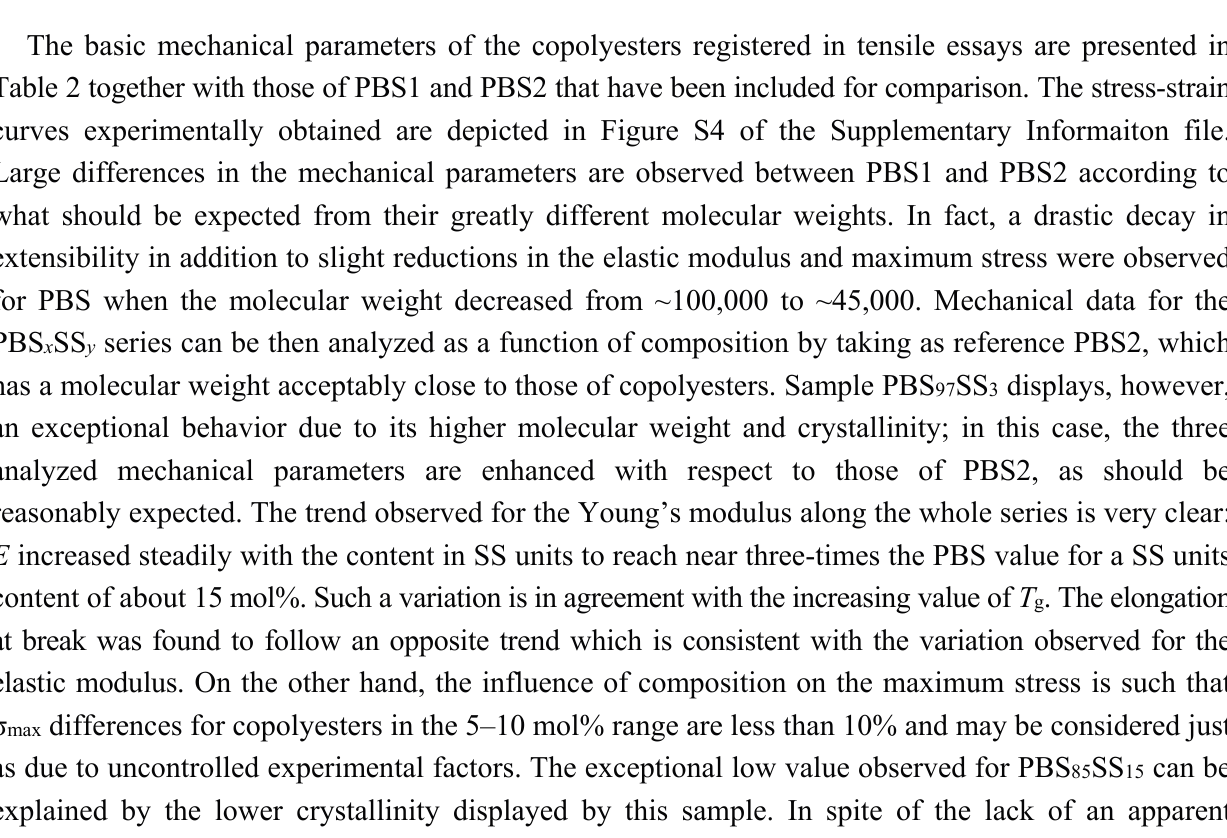
Figure 3. DSC thermograms (first heating) of PBS x SS y copolyesters and